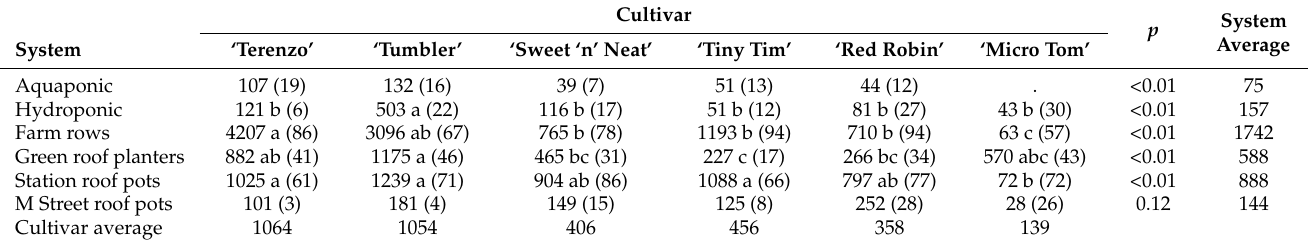
Table 2. Mean mass (percentage of non-marketable mean mass of the total mean mass), in grams, of non-marketable cherry tomatoes per plant across six cultivars and six systems. Means with different letters within a row are different (Tukey–Kramer means separation test, p <